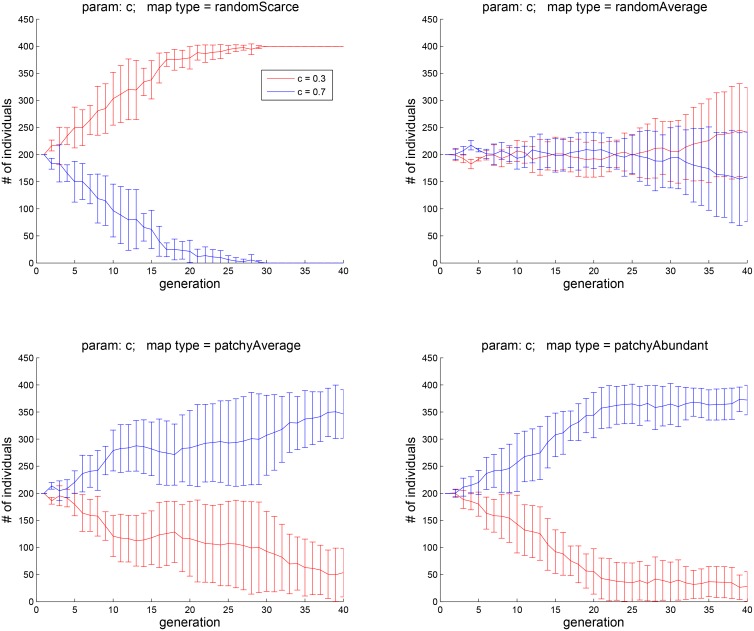
Experiment 1B: here, subpopulations with two values of c, 0.3 and 0.7, were pitched against each other.The lower value, corresponding to immediate or hedonic well-being H contributing less to motivation, appears to be advantageous only in the scarce-food environment. The higher value of c, is more advantageous when food is patchy and not rare to find.